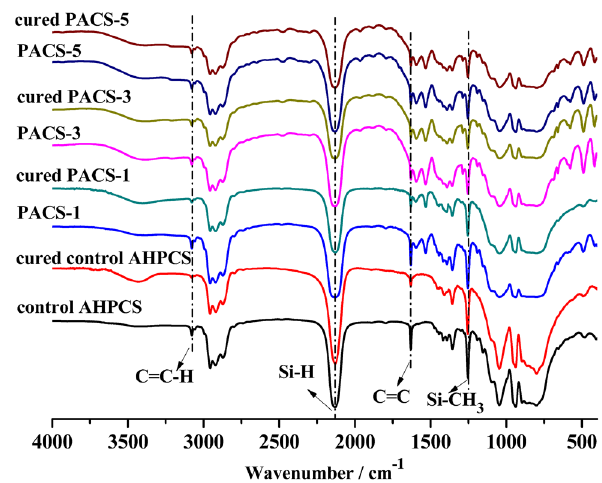
Figure 5. The chemical shift in NMR of – CH